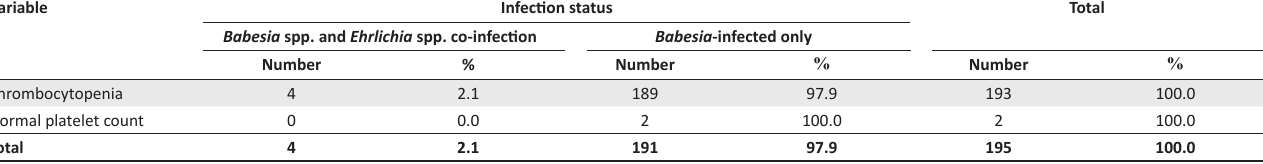
TABLE 3: Contingency table illustrating the relationship between infection status and platelet count. Variable